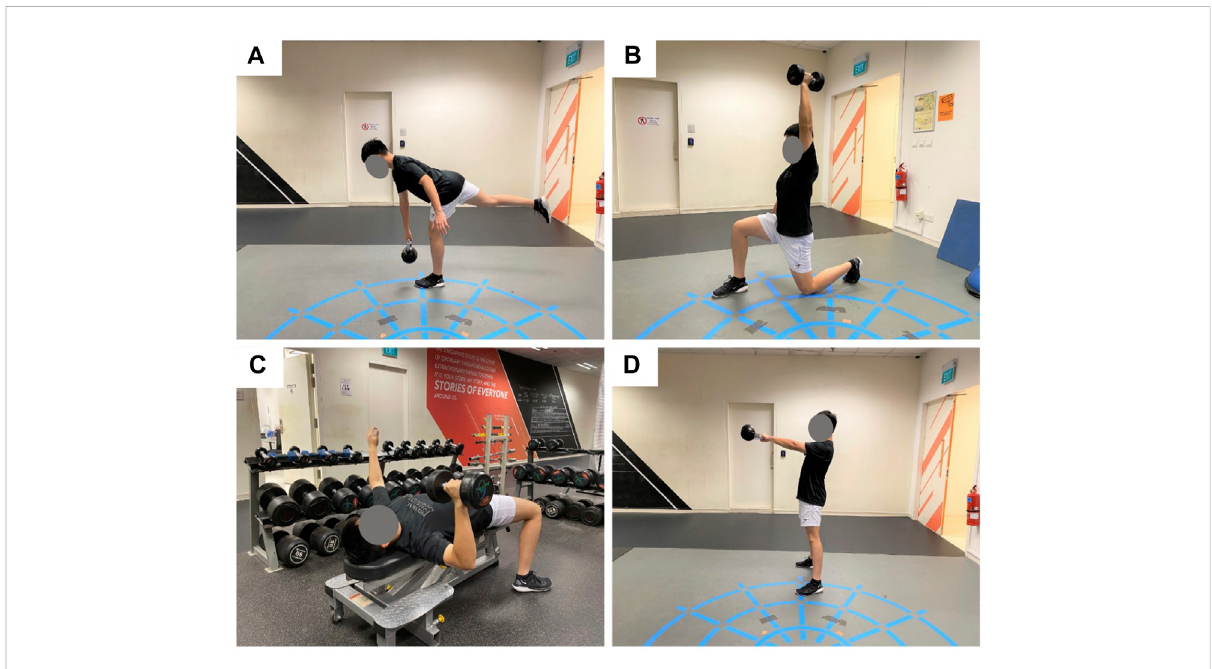
FIGURE 2 Example of Functional training exercises that are bilaterally asymmetrical and/or involve diagonal loading. (A) Single leg kettlebell deadlift. (B) Single arm dumbbell press. (C) Single arm chest press. (D) Kettlebell swing.